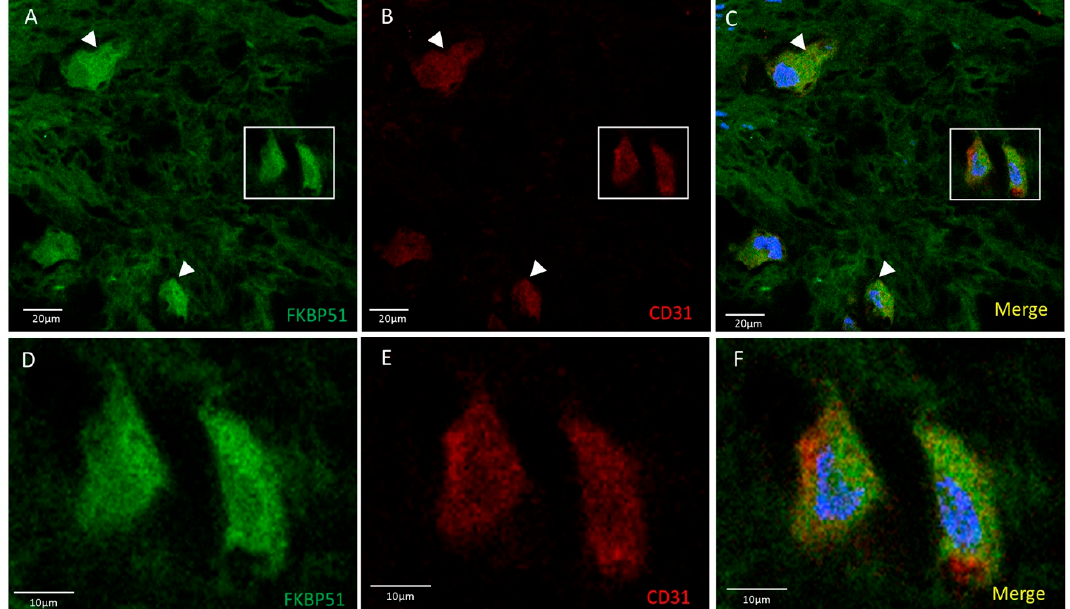
Figure 2. Double immunolabelling for FKBP51 and CD31 in tibial plateau cartilage sections from knee OA grade IV, square for higher magnification of stained chondrocytes ( D – F ). Merges also contain DAPI labelling. ( A – C ) FKBP51+/CD31+ cells were observed with a homogeneous staining intensity